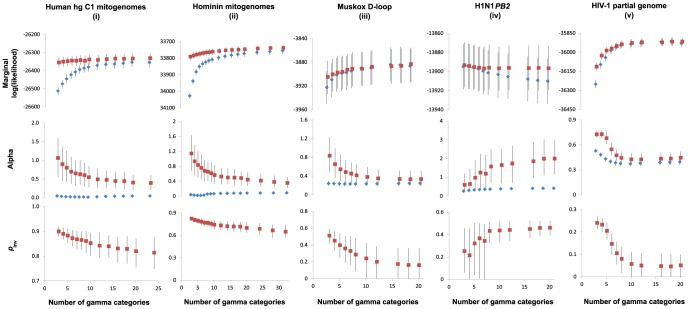
Bayesian phylogenetic estimates of various parameters against number of gamma rate categories for five intraspecific DNA data sets.From top to bottom, rows show estimates of marginal likelihood, the gamma shape parameter (α), and the proportion of invariable sites (p
inv). Filled blue and empty red markers represent parameter estimates using +Γ and +Γ+I models, respectively.